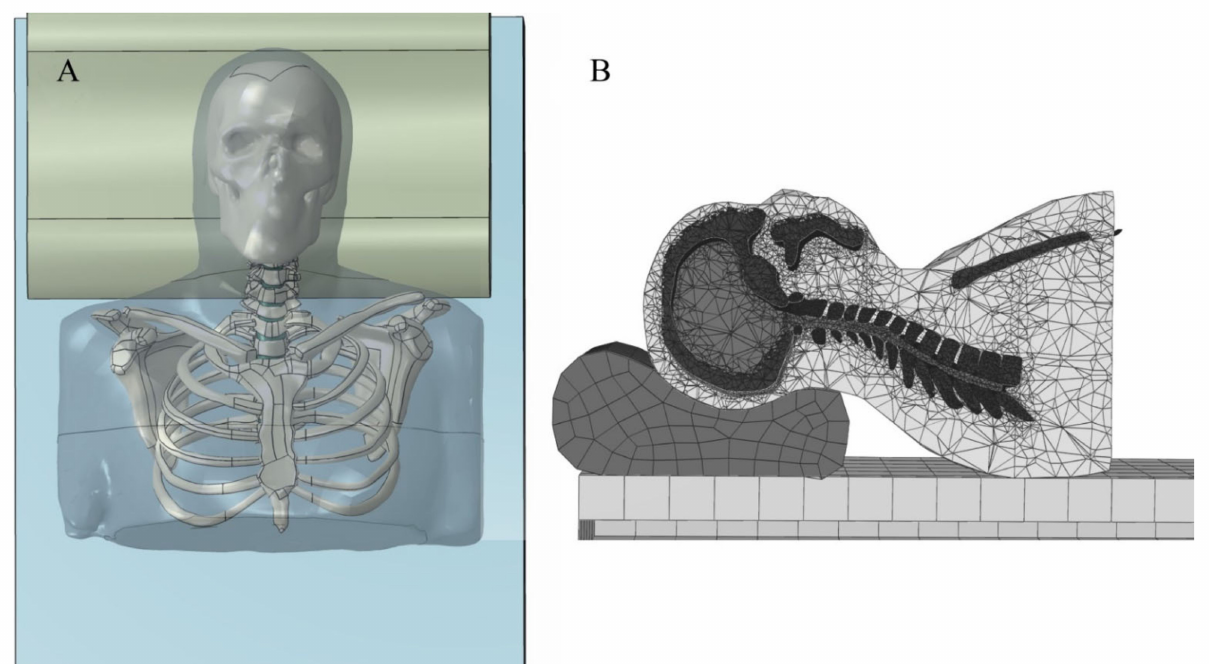
Figure 6. Finite element model of head and neck: ( A ) frontal view; ( B ) side view [22] (open